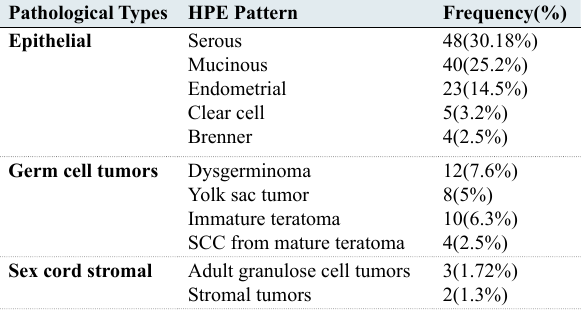
Table 1: Histopathological pattern of ovarian malignancies